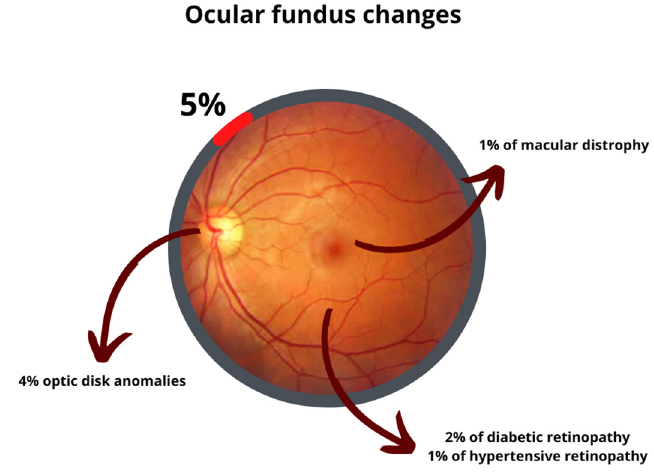
Figure 4. Principal retinal findings of the screened migrants within the PROTECT project. Of note, in certain cases, multiple findings coexisted in the same patient.